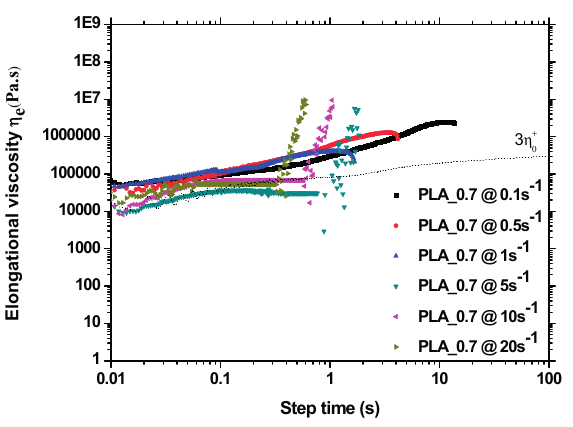
Figure 10. Start-up elongation viscosity versus step time for the modified PLA with 0.7 wt% of Joncryl at different elongation rates at 180 °C.